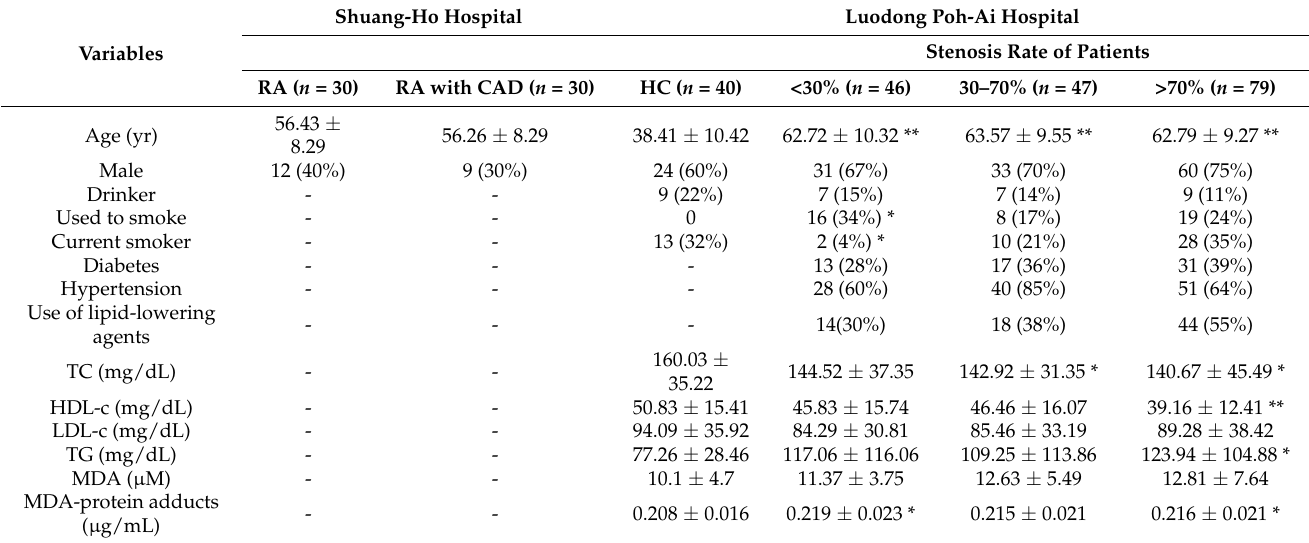
Table 1. Demographic and clinical characteristics of individual subjects contributing to plasma for healthy controls (HCs) and coronary artery disease (CAD) patients with <30%, 30~70%, and >70% stenosis rates.